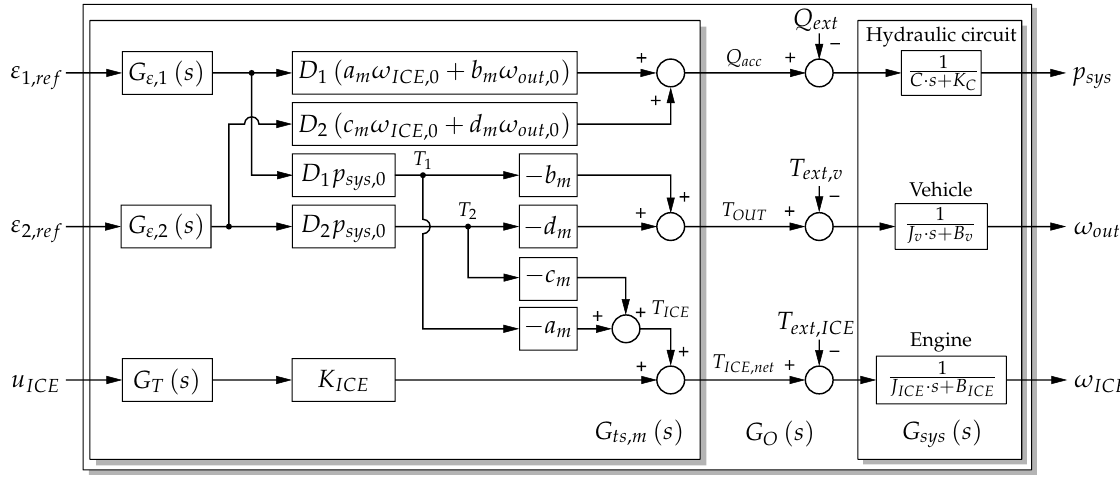
(cid:0) (cid:1) p sys ,0 , ω out ,0 , ω ICE ,0 .